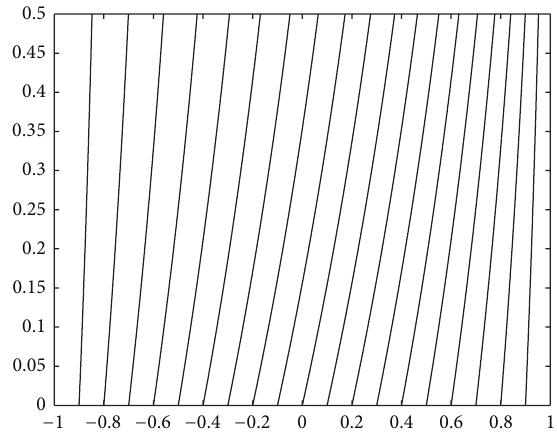
Figure 1: Graph of solution 𝑢 𝑡 + 𝑢 𝑥 + 𝑢 = 0 , 𝐴 = 1 .